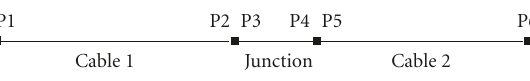
Figure 6: Configuration scheme with two cables separated by one junction.